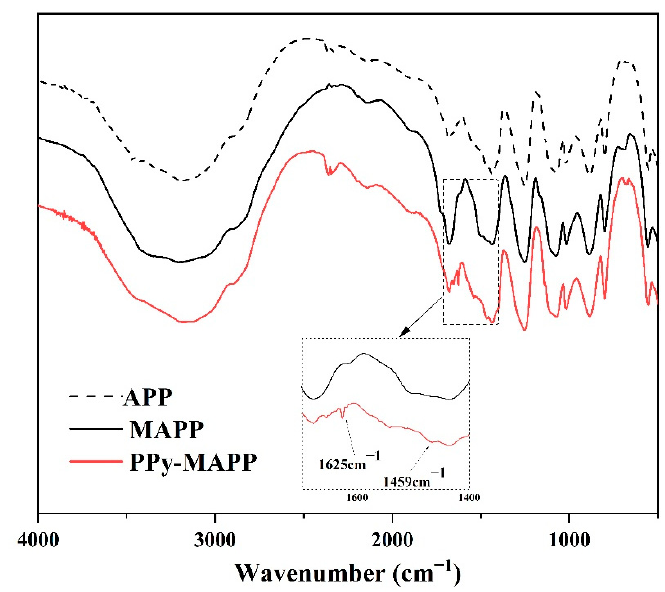
Figure 2. FTIR spectra of APP, MAPP and PPy-MAPP.